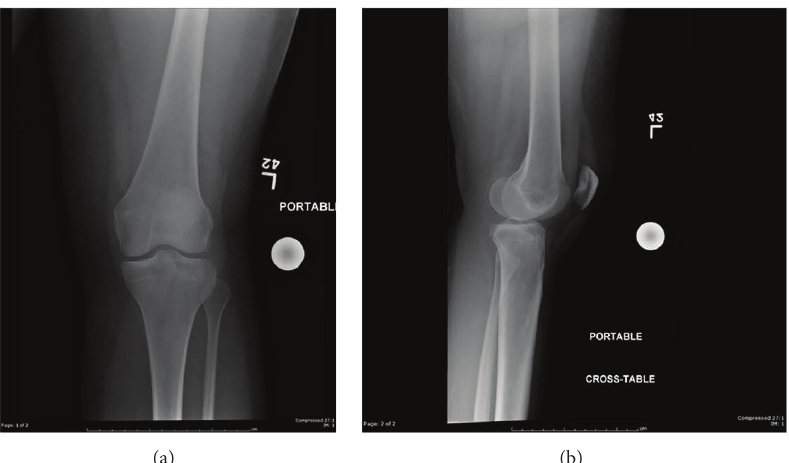
Figure 1: AP and lateral plain radiographs of the left knee showing a nondisplaced, vertically oriented fracture of the lateral tibial condyle.